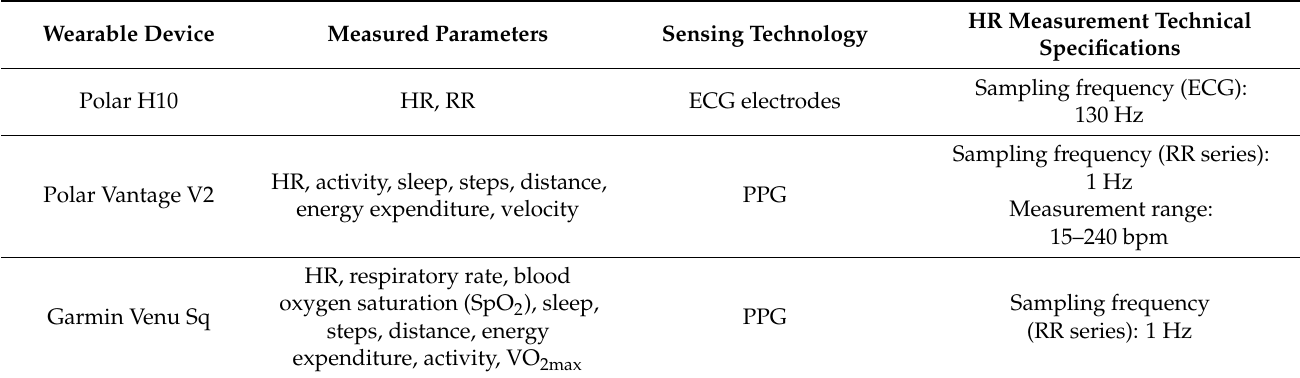
Table 2. Technical specifications of the wearable devices employed in the study.